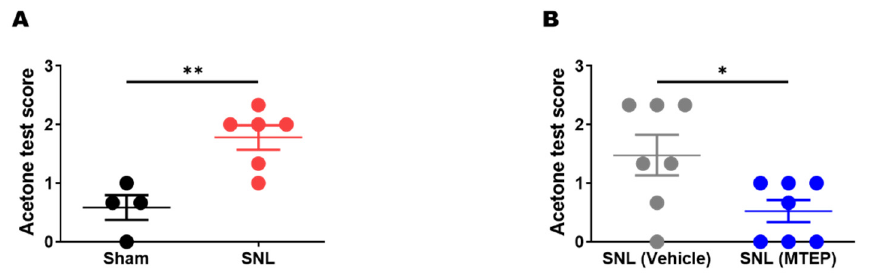
Figure 3. Microinjection of the mGluR5 antagonist into the S1DZ ameliorated SNL-induced cold allodynia. ( A ) SNL group showed increased behavioral responsiveness in the acetone test, indicating cold allodynia (** p < 0.01; two-sample t -test; sham = 0.58 ± 0.20, n = 4; SNL = 1.78 ± 0.20, n = 6). ( B ) Microinjection of mGluR5 antagonist MTEP into the S1DZ ameliorated cold allodynia symptom of SNL group (* p < 0.05; two-sample t -test; Vehicle = 1.48 ± 0.35, n = 7; MTEP = 0.52 ± 0.19, n = 7).